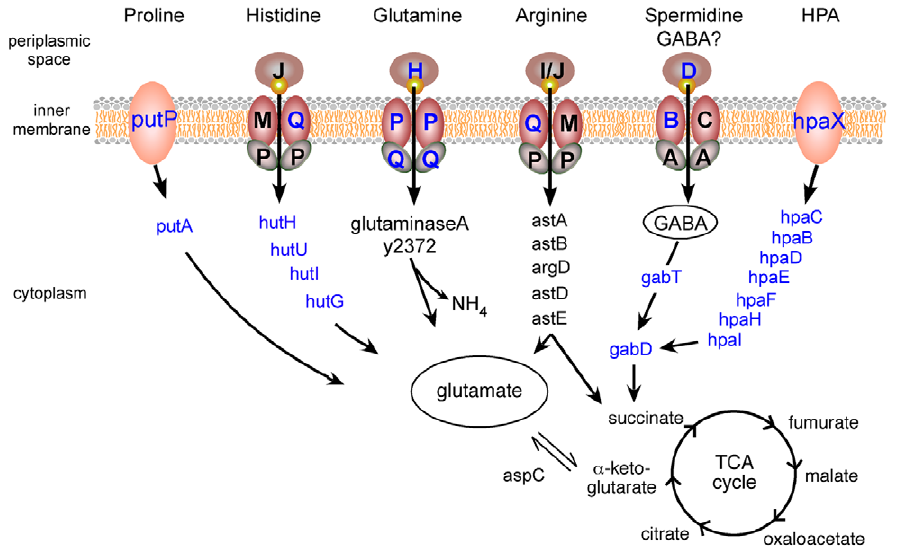
Figure 2. Y.pestis amino acid uptake and catabolism pathways upregulated in the flea. Periplasmic and inner membrane uptake proteins for proline (PutP), histidine (HisJMPQ), glutamine (GlnHPQ), arginine (ArtIMPQ), spermidine (PotABCD), and hydroxyphenylacetate (HpaX) are indicated from left to right. Genes encoding catabolic enzymes leading to glutamate and TCA cycle intermediates are also shown. Symbols labeled in blue indicate genes upregulated $ 2-fold in the flea compared to all in vitro conditions (Table